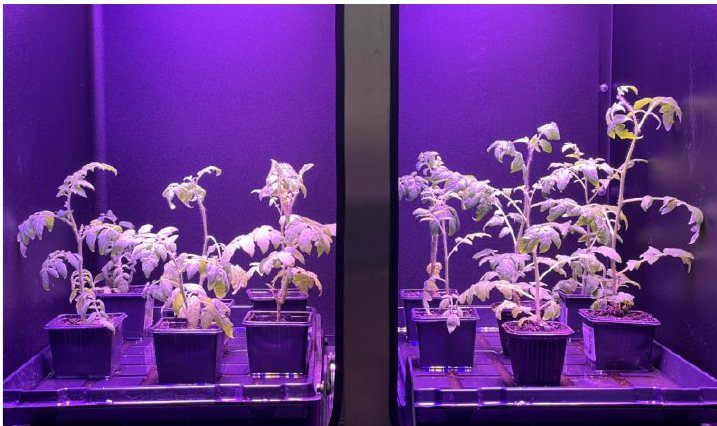
Figure 3. Photo of tomatoes grown under glass coated with a fluoroplate polymer without ( left ) or with ( right ) photoconversion nanoparticles.